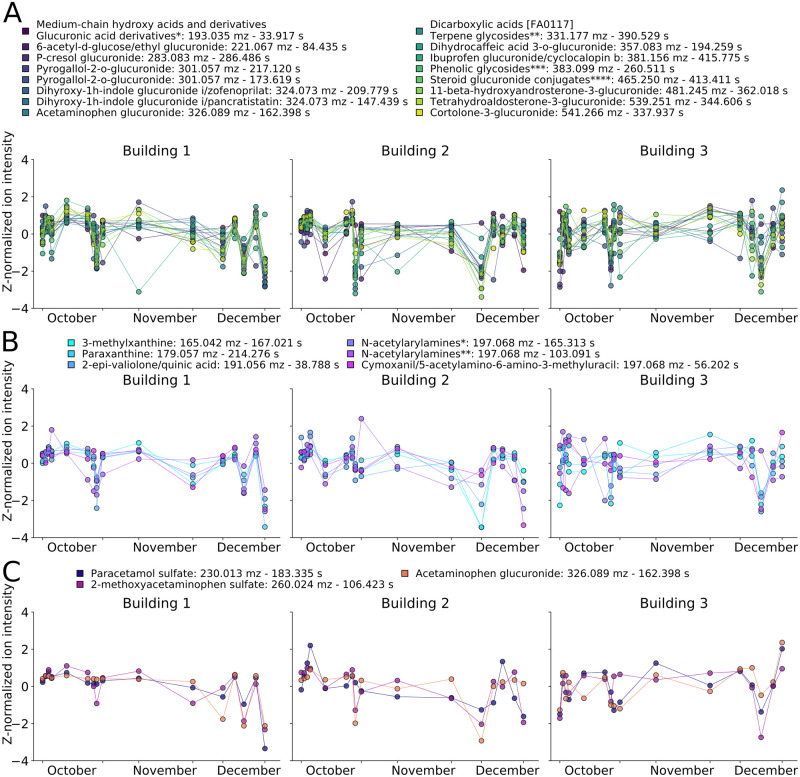
High temporal sampling allows for monitoring putative metabolite levels and dynamics in a building-specific manner.Z-normalized time courses of metabolites with MS level 2 identity, subclass names are supplied when several putative metabolites matched for (A) glucuronide-related, *5-dehydro-L-gluconate / D-glucuronic acid / iduronic acid / 5-keto-D-gluconate, **neomenthol-glucuronide / (2s,3s)-2-hydroxytridecane-1,2,3-tricarboxylate / lmfa13010036 / ***5-(3’,5’-dihydroxyphenyl)-gamma-valerolactone 3-o-glucuronide / 5-(3’,4’-dihydroxyphenyl)-gamma-valerolactone-4’-o-glucuronide, ****3-alpha-hydroxy-5-alpha-androstane-17-one 3-d-glucuronide / etiocholanolone glucuronide (B) caffeine-related, *5-acetylamino-6-amino-3-methyluracil / 6-amino-5[n-methylformylamino]-1-methyluracil, **5-acetylamino-6-amino-3-methyluracil / 6-amino-5[n-methylformylamino]-1-methyluracil and (C) acetaminophen-related putative metabolites across the three buildings. Full metabolite details can be found in S4 Table.